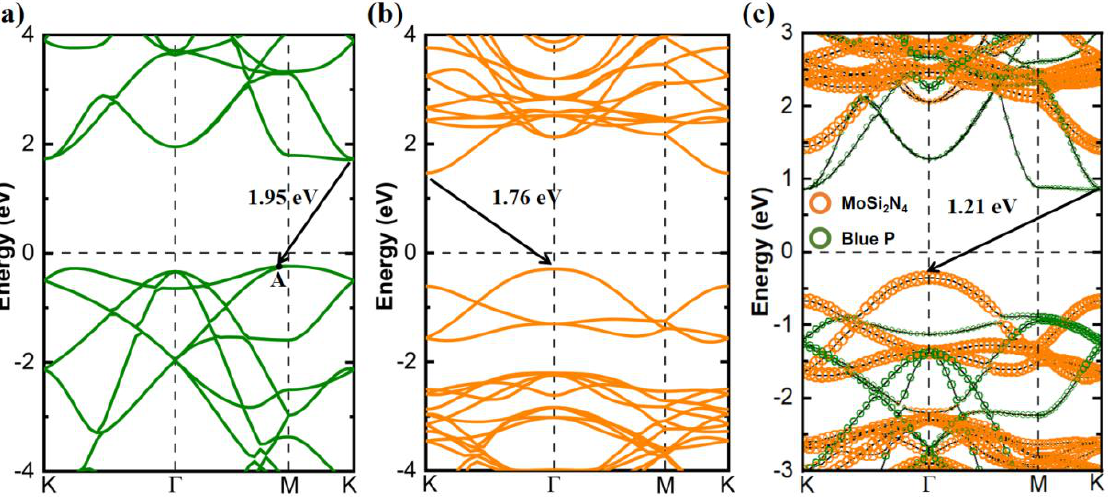
√ √ Figure 3. Band structures for ( a ) the √3 × √3 × 1 supercell of Blue P ML and ( b ) the 2 × 2 × 1 Figure 3. Band structures for ( a ) the 3 × 3 × 1 supercell of Blue P ML and ( b ) the 2 × 2 × 1 supercell of MoSi 2 N 4 ML. ( c ) Projected band structure of Blue P / MoSi 2 N 4 vdWH. Here, the Fermi supercell of MoSi 2 N 4 ML. ( c ) Projected band structure of Blue P/MoSi 2 N 4 vdWH. Here, the Fermi levels were set to zero. levels were set to